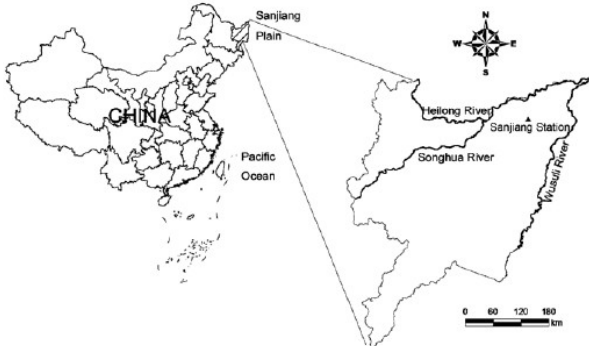
Fig. 1. The location of the Sanjiang Plain, Northeast China (Wu, Fig. 1 The location of the Sanjiang Plain, Northeast China (Wu, 2009) 458 2009).